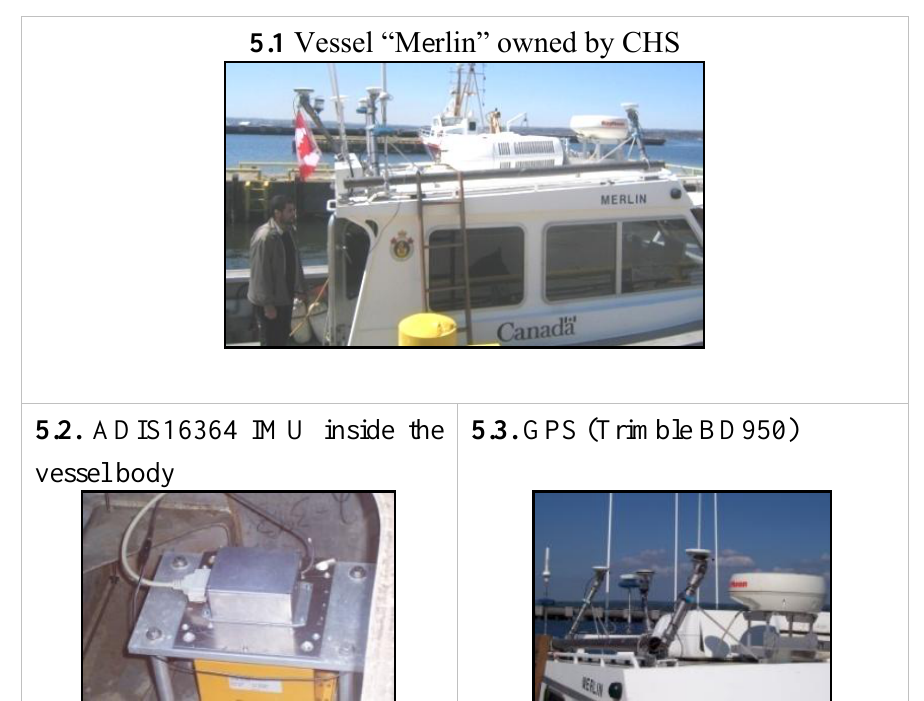
Figure 5. Field system used to collect kinematic